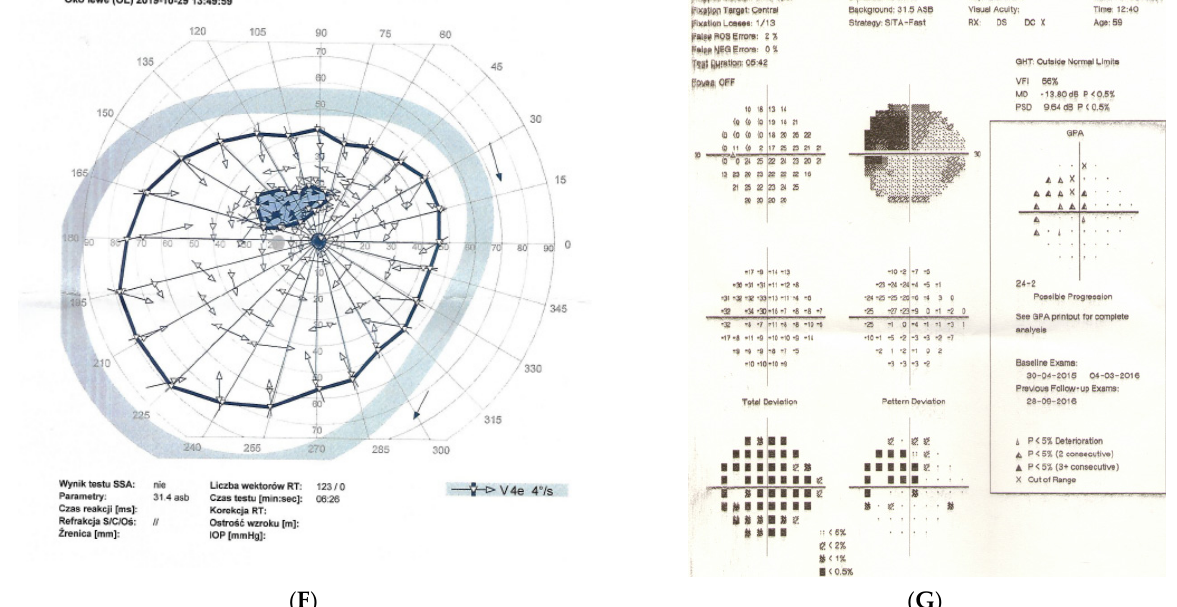
Figure 2. A 56-year-old male with intracranial meningioma. ( A ) Optic disc right eye. ( B ) Optic disc left eye. ( C ) Visual field right eye 01.2013 at the time of trabeculectomy. ( D ) Visual field left eye 01.2013 at the time of trabeculectomy. ( E ) MRI scan with visible intracranial meningioma. ( F ) Semikinetic visual field (SKP) left eye 10.2019 after neurosurgical procedure. ( G ) Visual field left eye 05.2021. Figure 3: An 82-year-old male was treated for NTG elsewhere but referred to our clinic